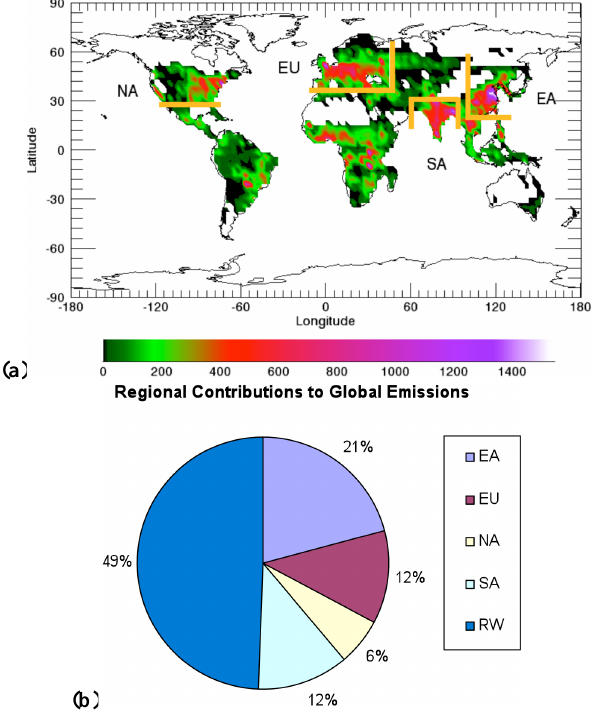
Fig. 1. (a) Emissions distribution of BC in kgC/km 2 /year. All emis- sions are applied constantly through seasons. Orange lines mark the boundaries separating major BC emission regions. (b) The percent- age contributions of regional BC emissions to the global